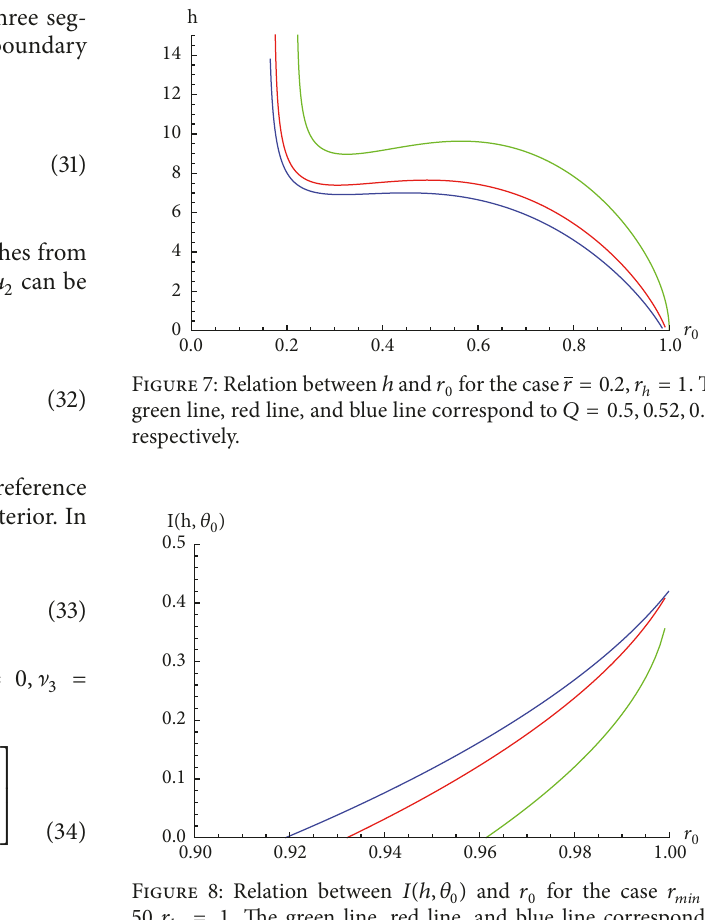
this case, 𝑟 0 󳨀→ 𝑟 ℎ . The corresponding horizontal axis of the critical point is labeled as 𝑟 0𝑐ℎ . In fact, for the plane symmetric black holes, [1] has obtained these results analytically. It was found that, at 𝑟 0𝑑ℎ , Ξ 3 diverges; thus ℎ approaches to